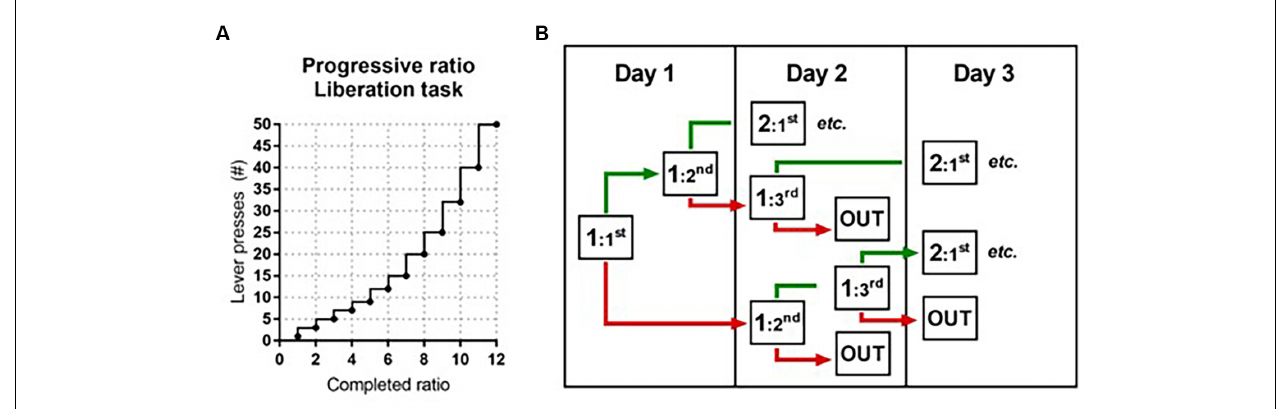
FIGURE 2 | Schematic representation of the adapted progressive ratio protocol in the liberation task. (A) The progressive increase in the number of required lever presses to complete a ratio and open the cylinder door(s) (adapted from Richardson and Roberts, 1996). (B) Decision tree in the liberation task. If during the first attempt on a given day rats reached the required number of lever presses (ratio completed; in green), a second attempt followed. If during the first attempt on a given day rats failed to reach the required number of lever presses (ratio not completed; in red), rats were tested again the next day. Rats needed to complete a given ratio twice in maximally three attempts. When they failed to do this, the preceding ratio was recorded as the maximum ratio